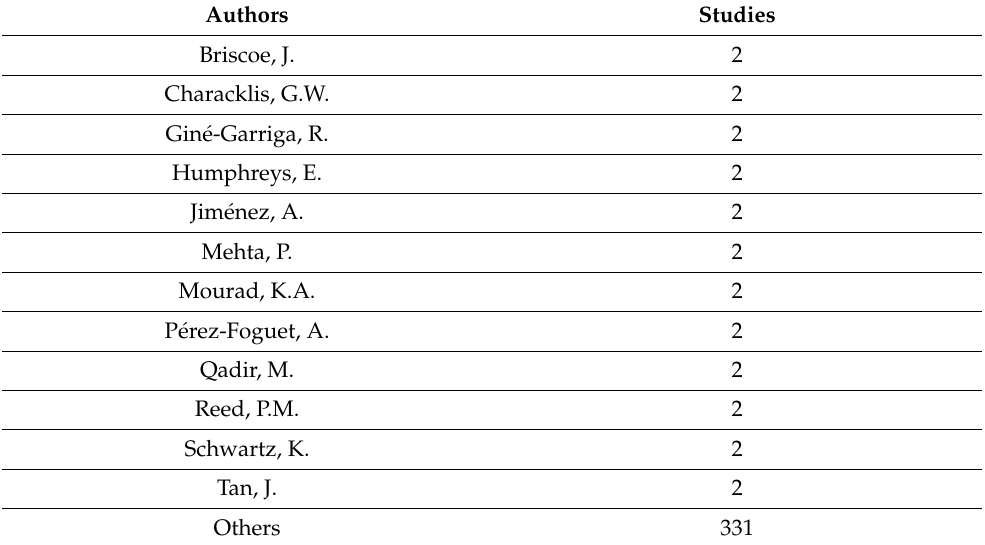
Table 3. Number of published studies by author.